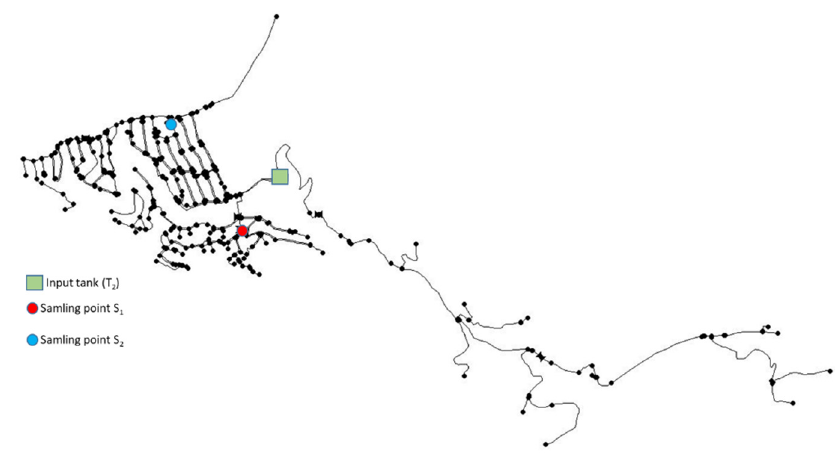
Figure 3. DMA network model in EPANET.